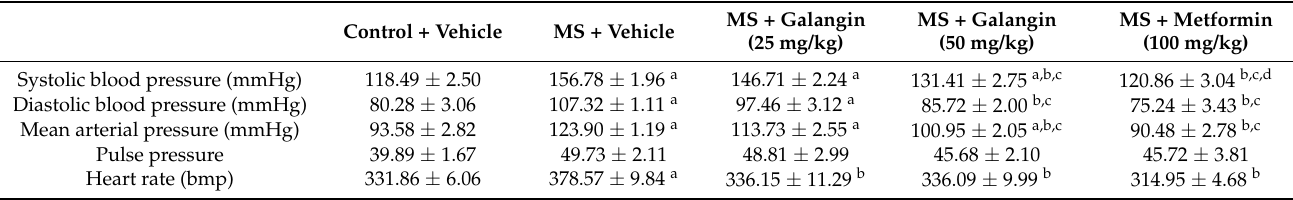
Table 3. Effects of galangin on blood pressure obtained from a direct method of blood pressure measurement in rats with high-fat diet-induced metabolic syndrome.